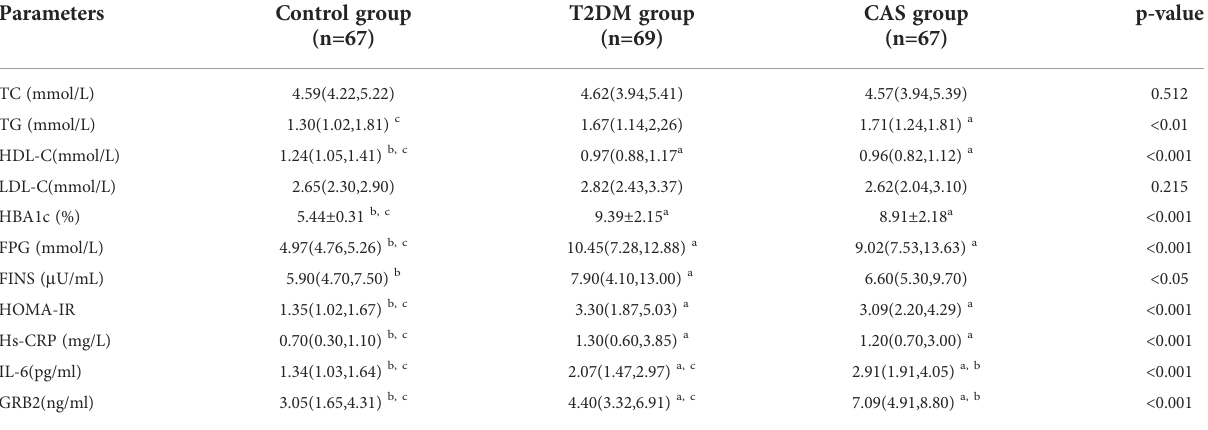
TABLE 2 Biochemical characteristics of the Control group, the T2DM group, and the CAS group. Parameters